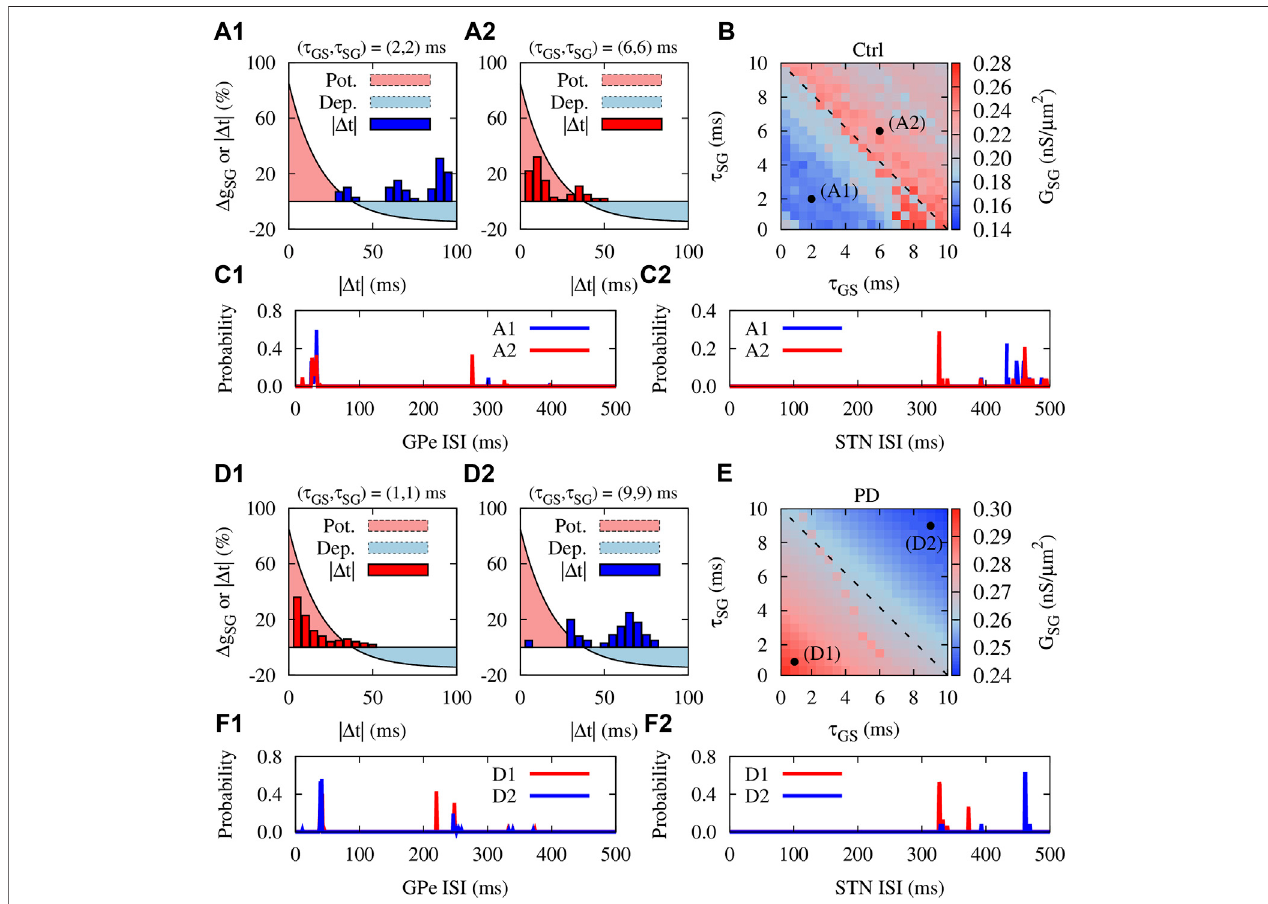
FIGURE6| Delaydependencyofactivity-connectivitystatesintheGPe-STNnetworkwithiSTDP.Controlcondition: (A1,A2) TheiSTDPpro fi ledescribedby Eq.4 depicted for positive time lags. Blue (A1) and red (A2) bars show the distribution of time lags between the fi ring of GPe and STN neurons obtained from numerical simulations for different transmission delays indicated above each panel. (B) Steady-state mean synaptic coupling in the pallido-subthalamic pathway for different feedforwardandfeedbacktransmissiondelays.Dashedlineindicates τ SG = − τ GS +10 ms. (C1,C2) ThedistributionofISIsoftheGPe (C1) andSTN (C2) neuronsin control condition for the range of delays used in panels A1 and A2. (D1 – F2) Same as (A1 – C2) , but for PD